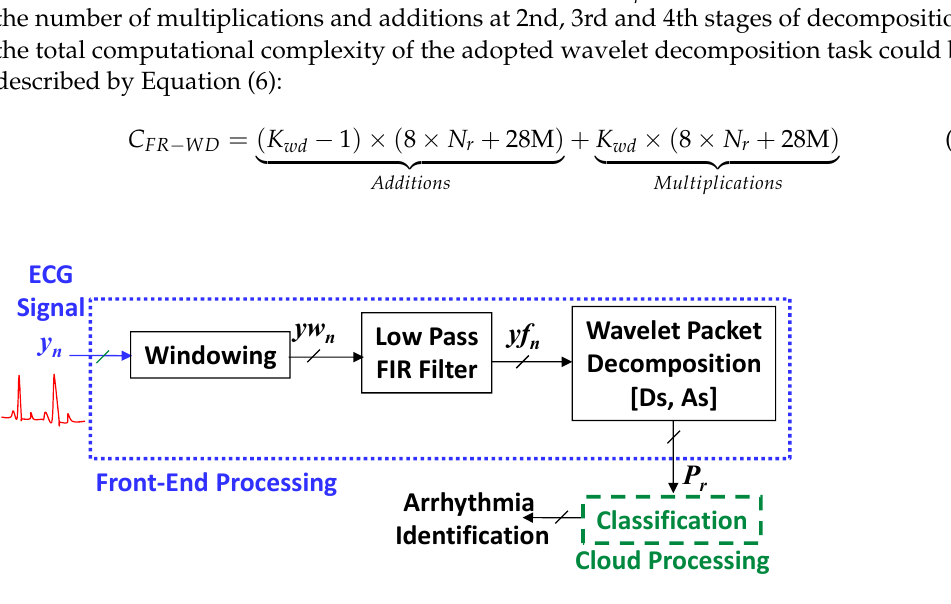
Figure 4. The classical fixed-rate approach block diagram.